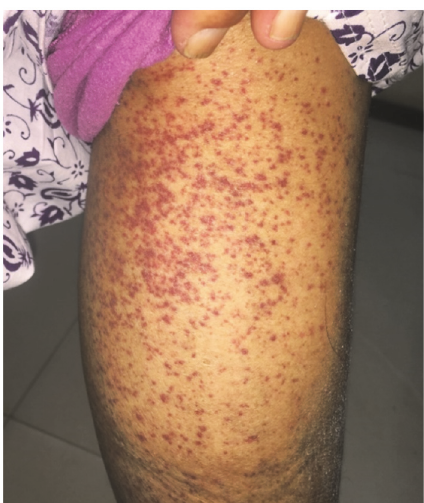
Figure 1: Palpable purpura on the lower limb.